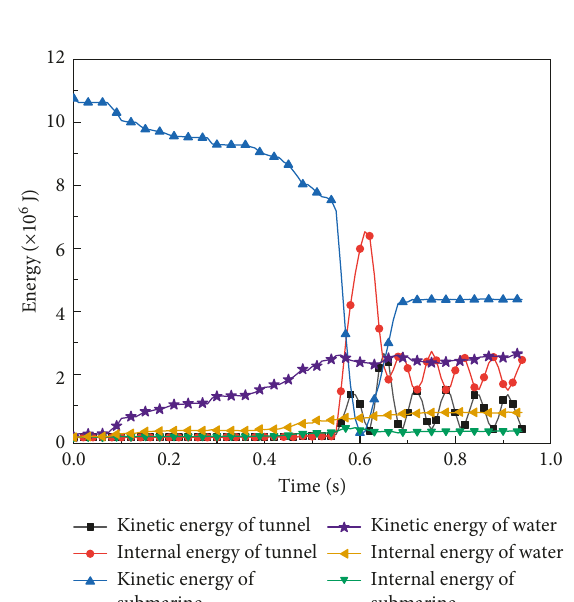
Figure 5: Global energy.